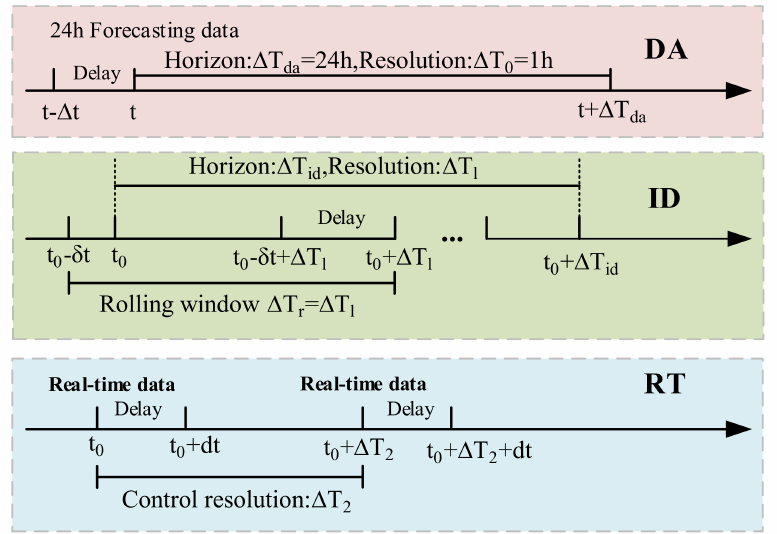
Figure 5. Framework of multi-stage optimization strategy